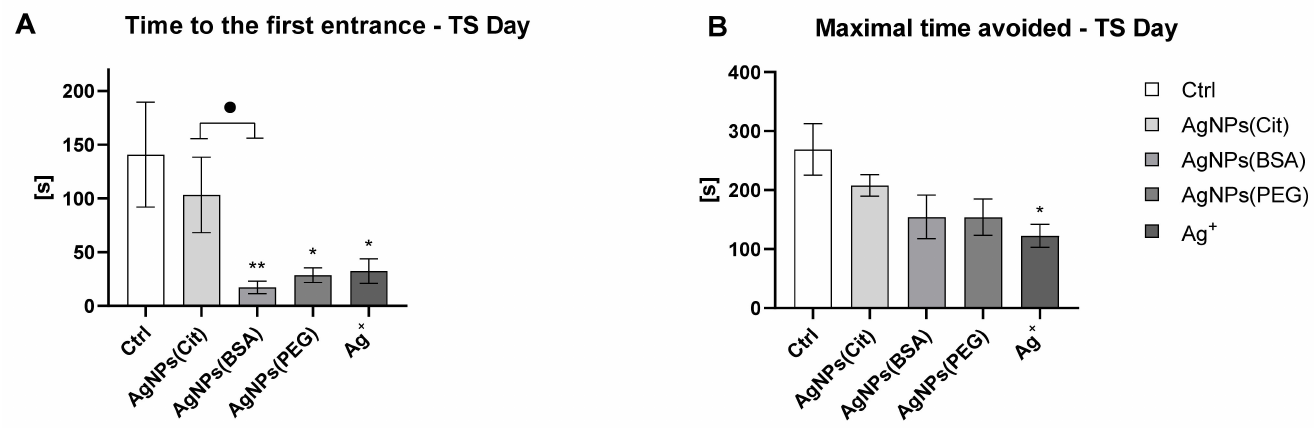
Figure 3. Retrieval test on long-term memory. ( A )—T1 measured on test (TS) day (one-way ANOVA: effect of group, F 4,30 = 5.91, p = 0.001) (mean ± SEM); ( B )—Tmax measured on TS day (one-way ANOVA: effect of group, F 4,30 = 5.91, p = 0.001) (mean ± SEM). * and **: Significantly different from the Ctrl group (* p < 0.05 and ** p < 0.01) (Tukey post hoc test). • Significantly different between the AgNPs(Cit) and AgNPs(BSA) group ( • p < 0.05) (Tukey post hoc